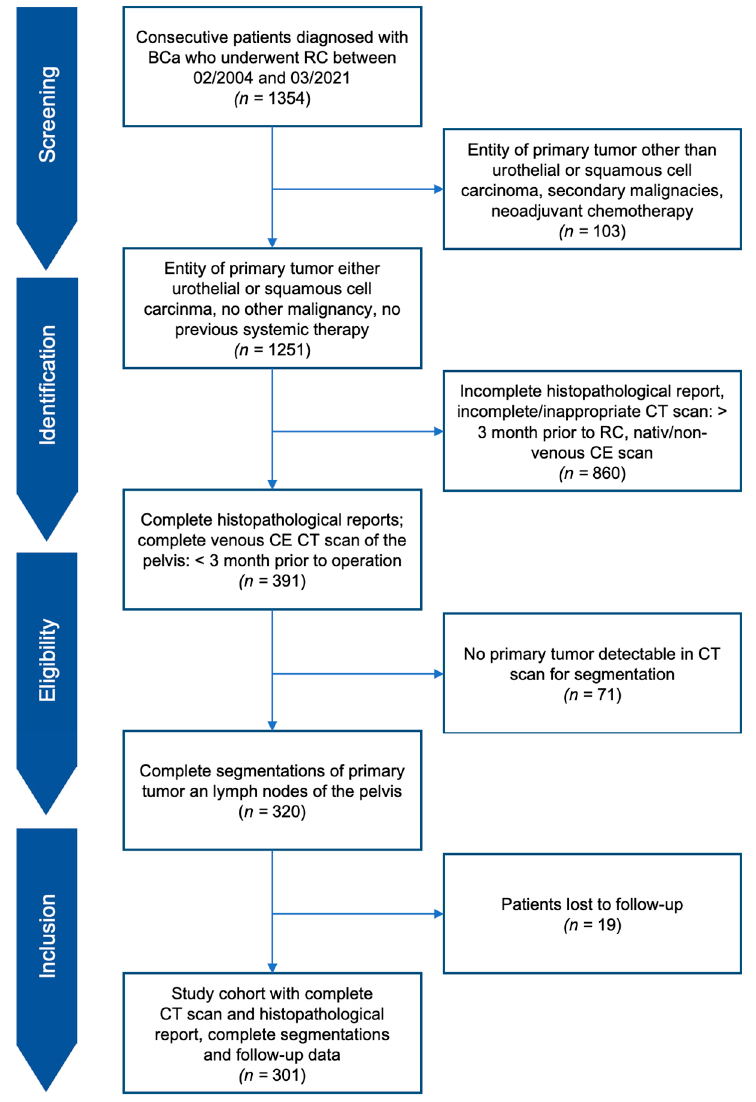
Figure 1. Study flow chart.